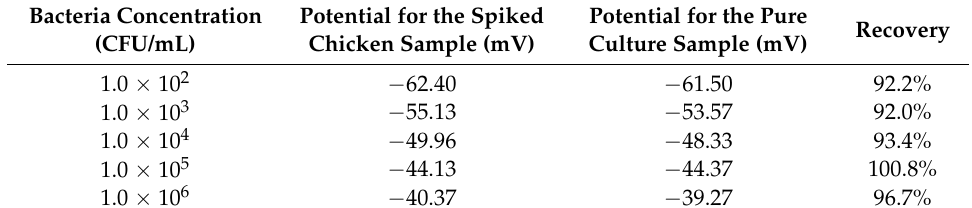
Table 1. Therecoveryofthe S. Typhimuriumcellsattheconcentrationsof1.0 × 10 2 –1.0 × 10 6 CFU/mL( N = 3). Table 1. The recovery of the S. Typhimurium cells at the concentrations of 1.0 × 10 2 – 1.0 × 10 6 CFU/mL ( N = 3).